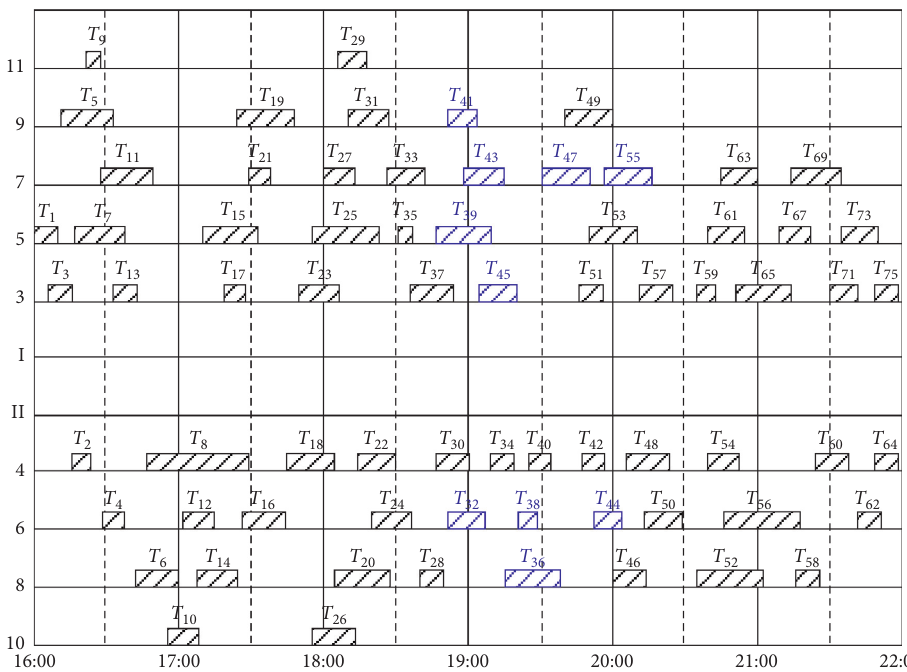
Figure 8: Initial platform track utilization scheme between 16:00 and